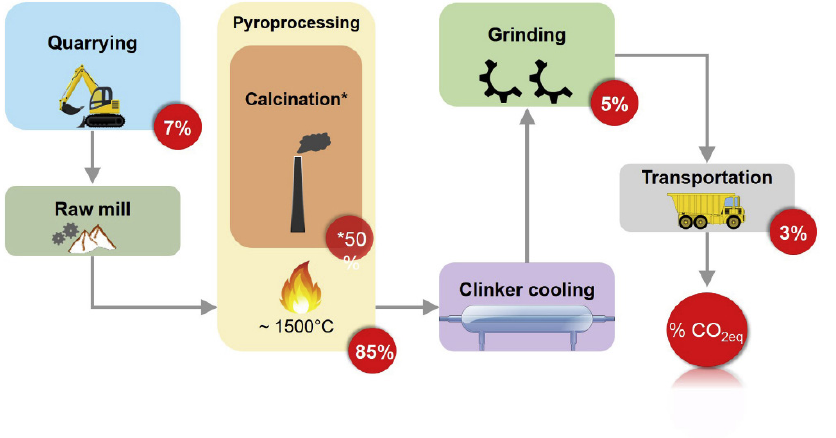
Figure 1. Diagram on PC manufacturing chain and the CO 2 emission rate (in percentage) associated with each stage (reproduced with permission from Maddalena, R. et al., Journal of Cleaner Production ; Elsevier, 2018).